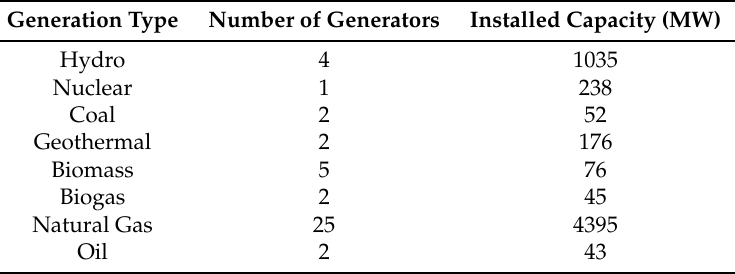
Table 1. Power test system generation